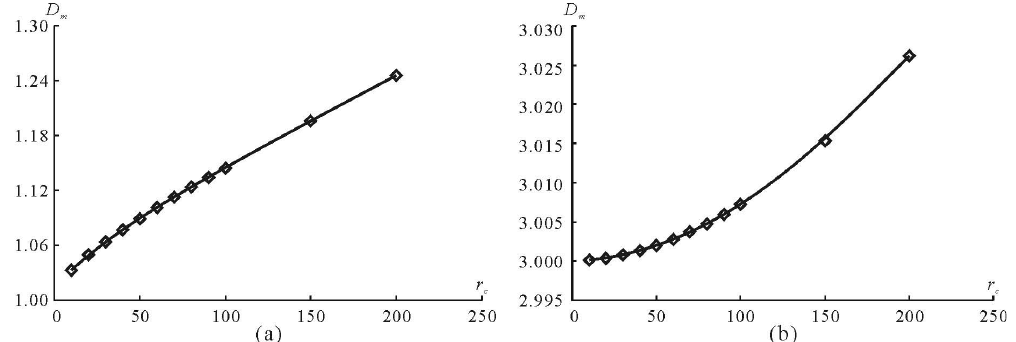
Fig. 4. Variation of fractal dimension D m in the number-average size model, obtained according to the Eqs. (10), (15) and (17), as size r c varies from 1 to 200 with r min = 1 and r max = 1000, when (a) D c = 0.2; and (b) D c = 3.